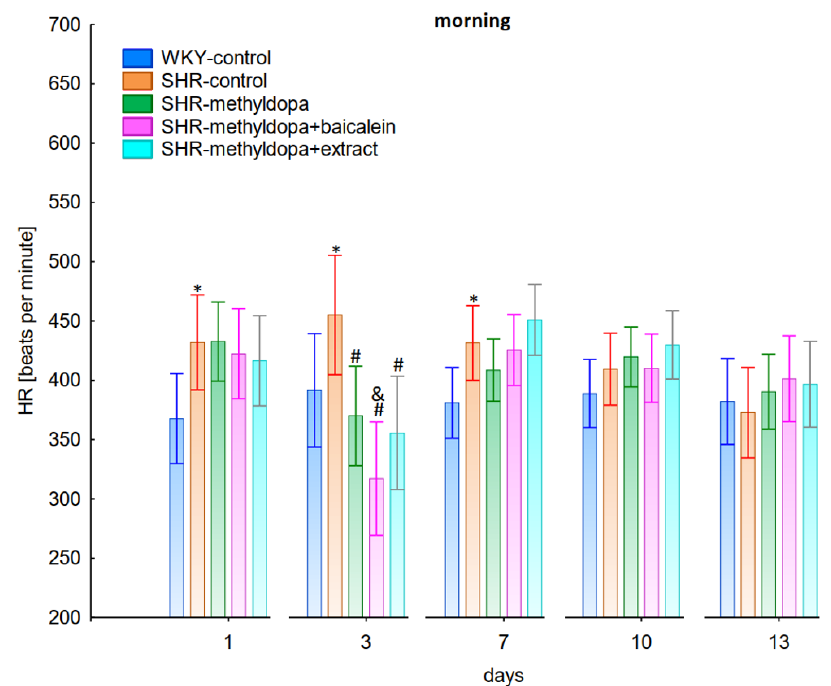
Figure 3. Influence of methyldopa and its combination with baicalein or extract from Scutellaria baicalensis roots on morning heart rate (HR) in SHR pregnant rats. Legend: n = 10, mean ± SEM; * — vs. WKY control, p < 0.05; # — vs. SHR control, p < 0.05; & — vs. SHR-methyldopa, p < 0.05. Administration of methyldopa significantly ( p < 0.05) reduced SBP compared to SHR control, whereas DBP and HR were significantly reduced by the drug ( p < 0.05) in SHR animals only on day three, while at the remaining time points the values did not differ significantly from the SHR control group (Figures 1 – 3).